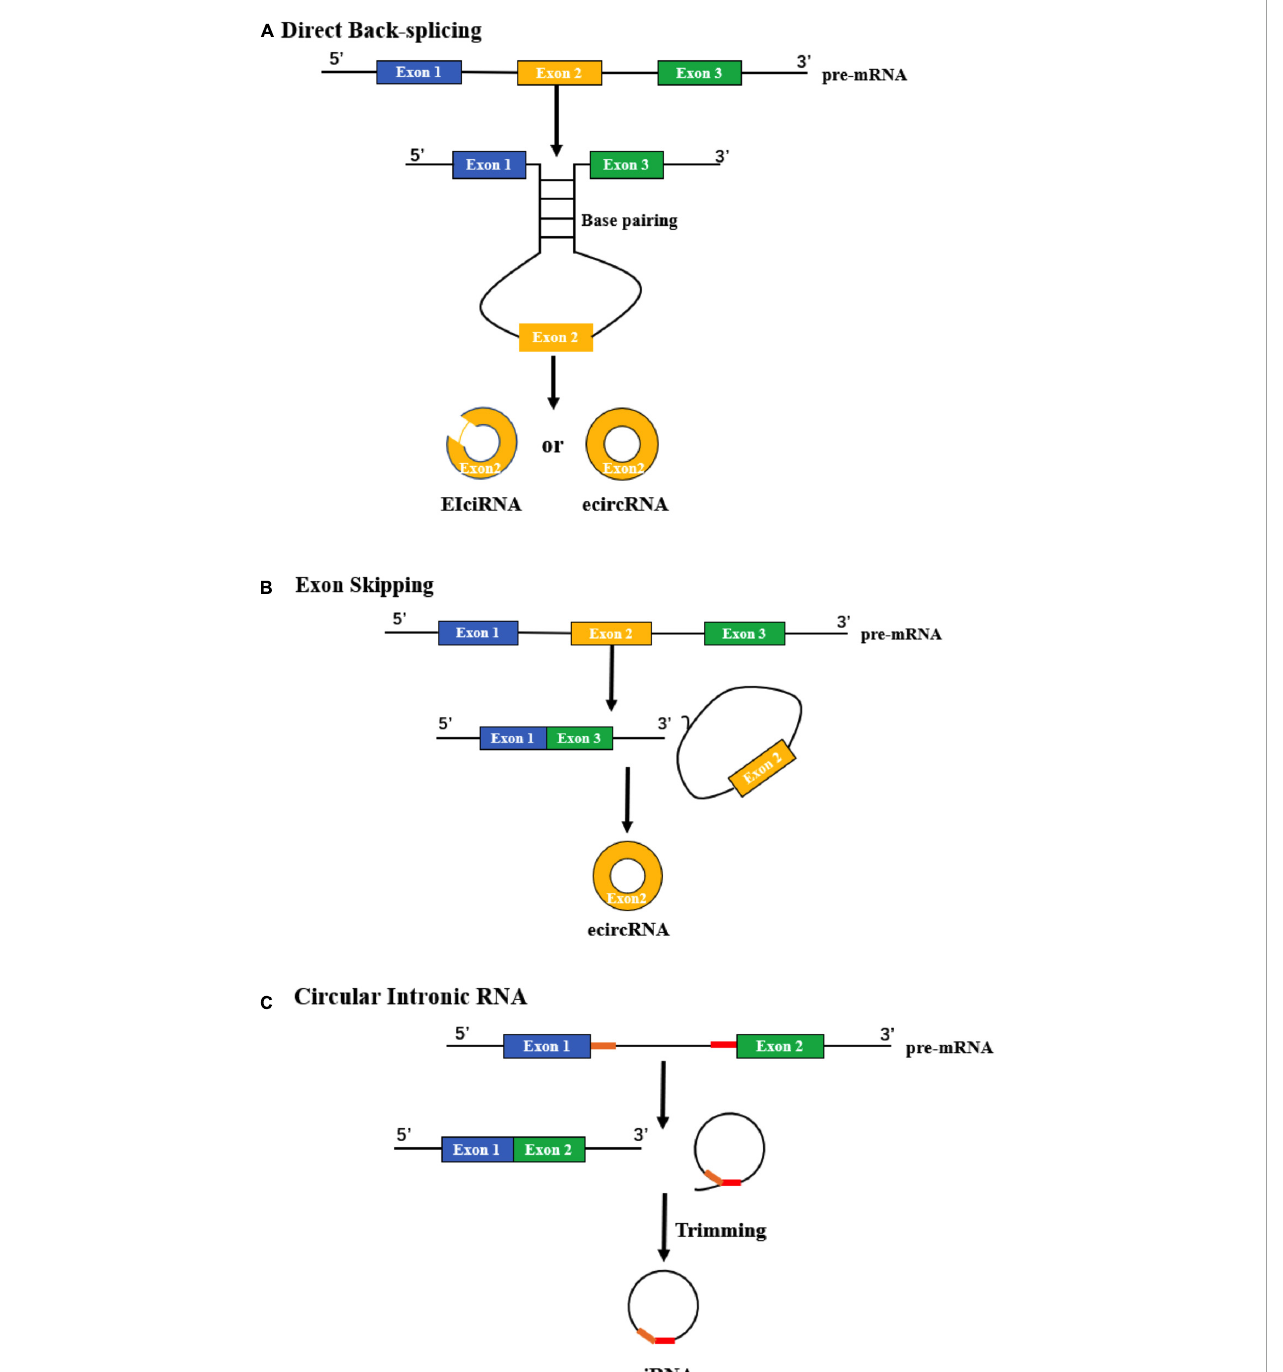
FIGURE1 Biogenesis of circRNAs. (A) Direct back-splicing occurs when an upstream intron and downstream intron pair with each other through complementarity, forming ecircRNAs or EIciRNAs. (B) The process of exon skipping begins with the splicing of pre-mRNA. Then, a lariat containing the exon (yellow) and introns is produced, after which an ecircRNA is generated. (C) The formation of ciRNA depends on two significant RNA elements (yellow and red), which enable an intron to escape debranching and degradation.